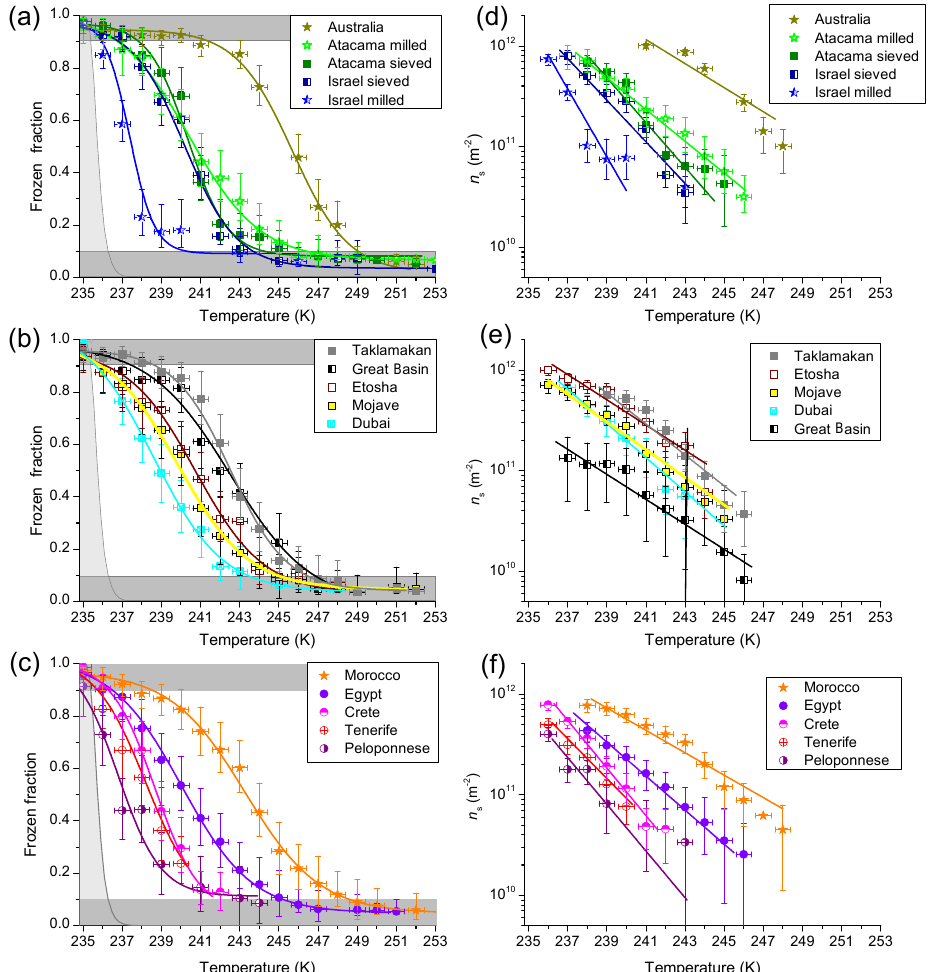
Figure 4. Frozen fraction of non-Saharan samples (panels a and b ) and samples originating in the Sahara (panel c ). Data were binned into 1K-intervals. Lines are best sigmoidal fits. Squares are surface-collected and sieved; stars are surface-collected and milled; circles are airborne samples. The light gray area is the homogeneous freezing regime derived from classical nucleation theory (Hoyle et al., 2011; Ickes et al., 2015) and the two dark gray rectangles show the upper and lower detection limits of IODE. Ice-active surface site density of non-Saharan (panels d and e ) and Saharan samples ( f ). Lines are best exponential fits to Eq. (6). The fit parameters are given in Table 4.